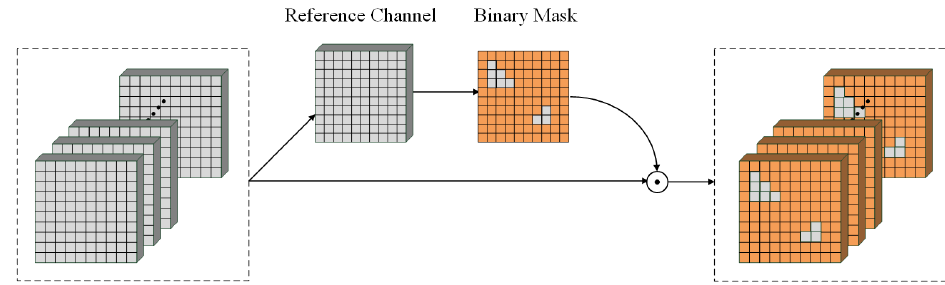
Figure 3. Illustration of FocusedDropout. The channel with the highest activation value is selected as the reference channel to generate the binary mask. After being covered by the mask, the units most likely to be related to the target will be retained, and the others will be discarded. The orange represents the neurons dropped by